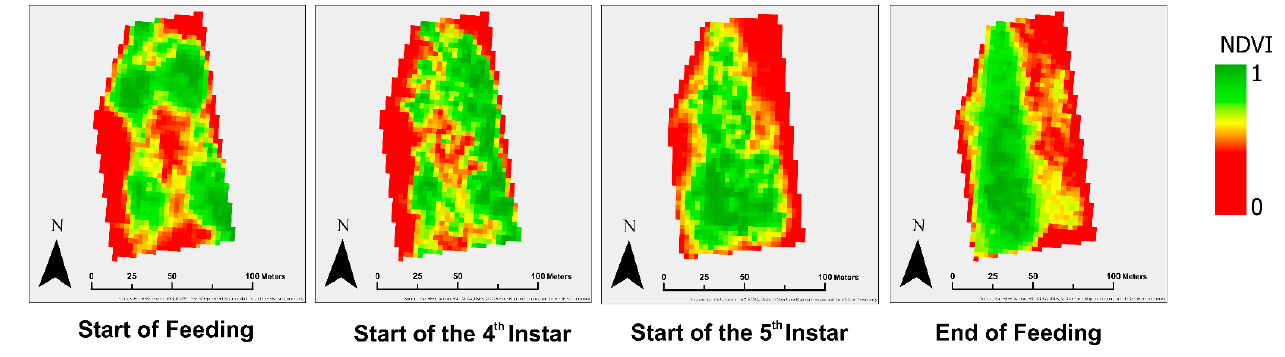
Figure 4. Spatial evolution of NDVI from the ID 03 M. alba field during 2021 rearing season.